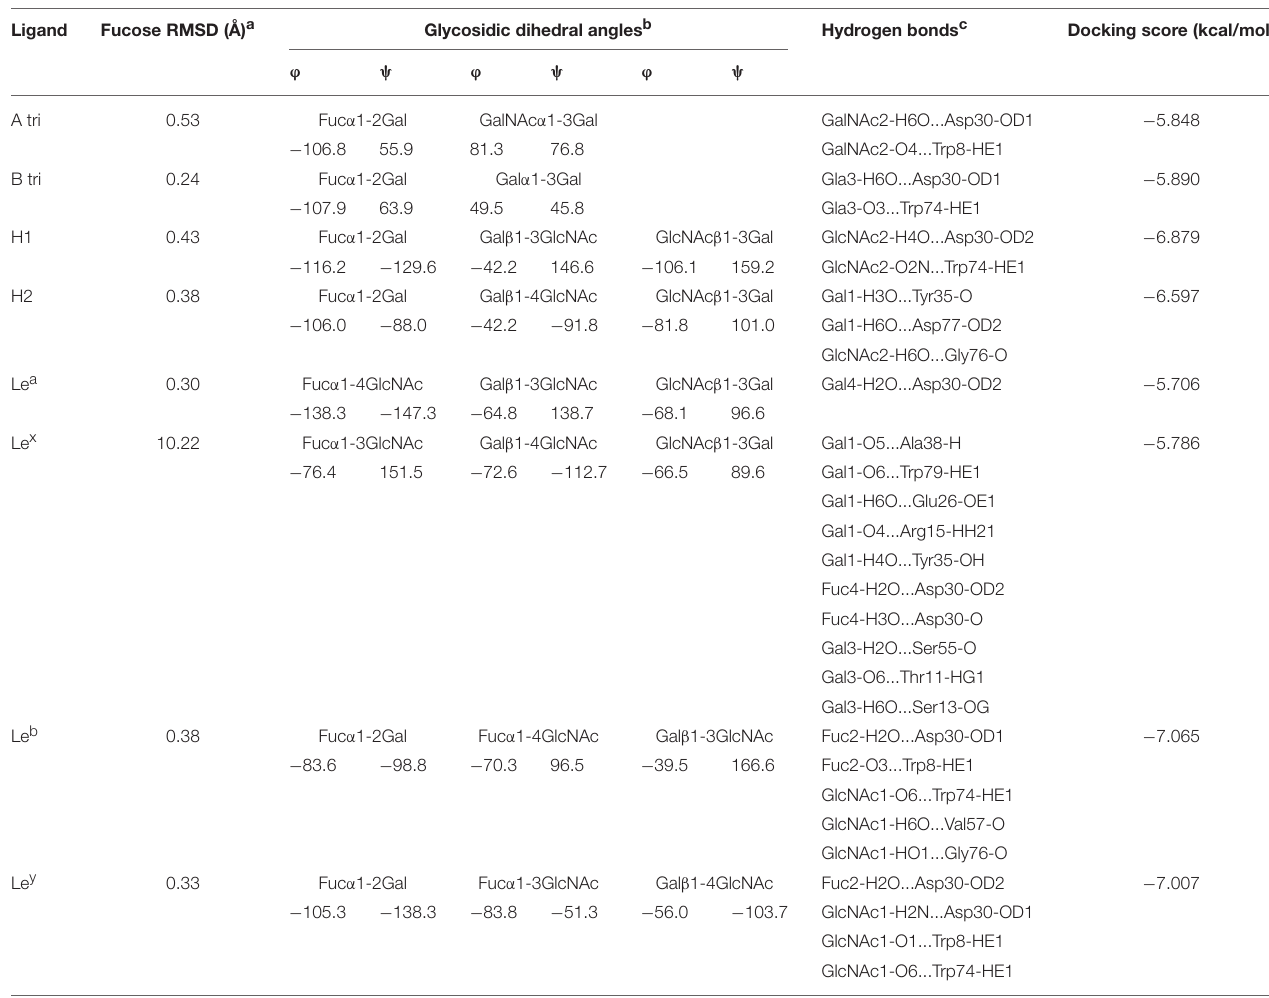
TABLE 2 | Top scoring docked pose characterization for BambL-blood group saccharide complexes.